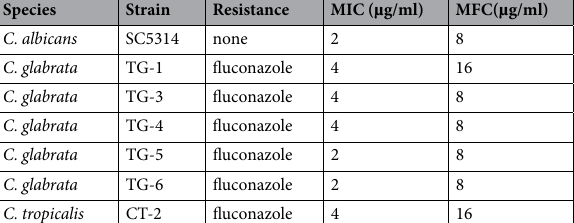
associated with this type of infection. We obtained clinical isolates of C. albicans , as well as non-albicans species (NAC), which are resistant to standard antifungal agents. The results shown in Table 1 demonstrate that C4 is active at the same level against all strains and species as with the index strain. This activity was not inhibited in the presence of 50% human serum (not shown), thus suggesting it would be active in vivo . To quantify the effect of this mimic on systemic Candida infection, we used a standard mouse model of dis- seminated candidiasis 34 . Mice were immunosuppressed with injections of cyclophosphamide, followed by intra- venous (IV) injection of 3.4 × 10 4 cfu C. albicans strain SC5314 (originally a clinical isolate from a disseminated infection). Two hours after infection, mice were injected IV with C4 as described. After 24 hours, mice were sacrificed, kidneys were homogenized and viable colonies of C. albicans were quantified. Figure 5a shows that even a single dose of C4 was sufficient to reduce viable Candida to one log below the level seen at the time of drug administration, indicating its fungicidal activity in vivo . Higher concentrations and repeated treatments led to a greater reduction in kidney burden. In a second experiment (with the same immunosuppression regimen and same number of injected Candida ), a long-term treatment was then carried out, with injection of the drug